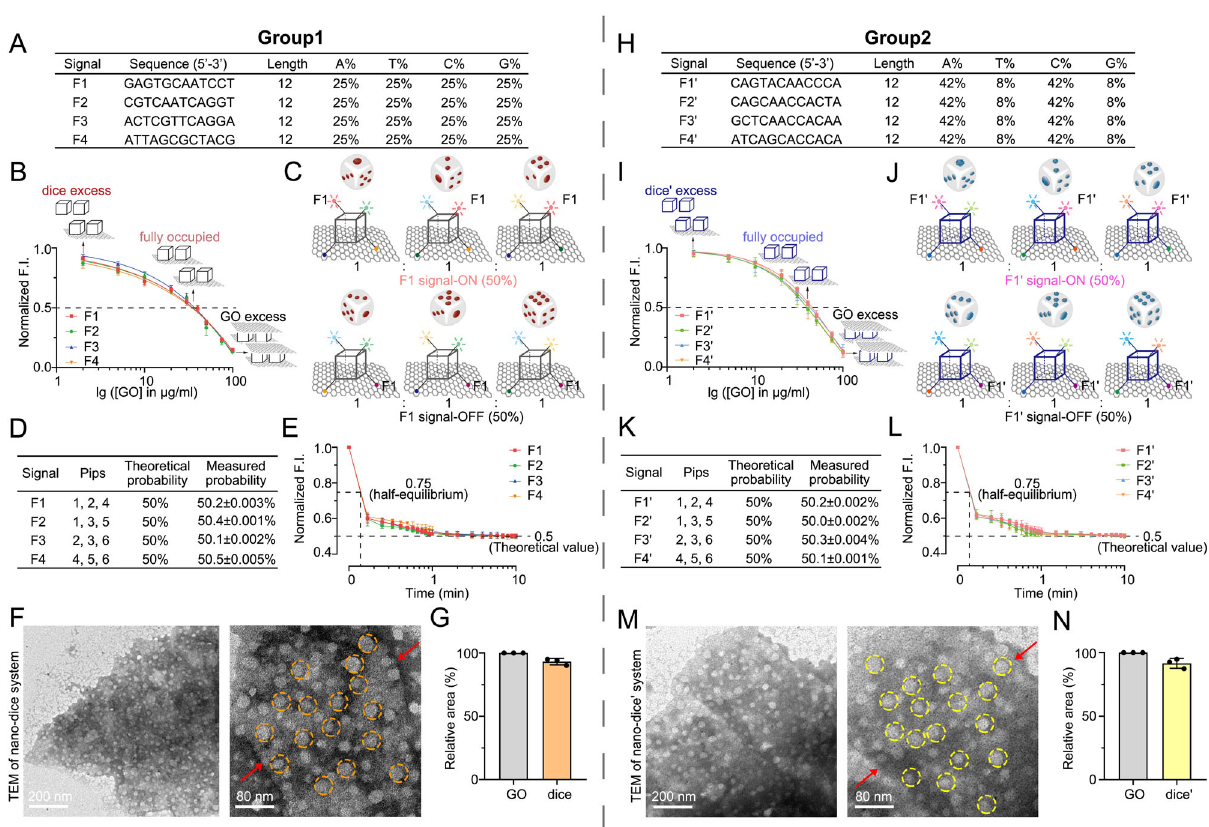
Fig.3|ThestochasticeffectperformanceofDNAnano-dicesystem.A Sequence information table of four signals in the nano-dice. B Concentration-dependent fl uorescence changes of four signals after the nano-dice was mixed with the GO, n =3 independent experiments. C Schematic illustration of the stochastic effect of the nano-dice system. D The result table of stochastic effect of the nano-dice sys- tem. E Time-dependent fl uorescence changes of four signals after the nano-dice was mixed with the GO (41.45 μ g/ml), n =3 independent experiments. F Negative- staining TEM for characterization of DNA nano-dice system. Red arrow: creases of GO.Orangecircle:DNAnano-dice(averagediameter:28.6±2.9nm).Thescalebars are 200nm and 80nm, respectively. G Quantitative analysis of the relative area of DNA nano-dice in GO (92.7±3.4%), n =3 independent samples. H Sequence